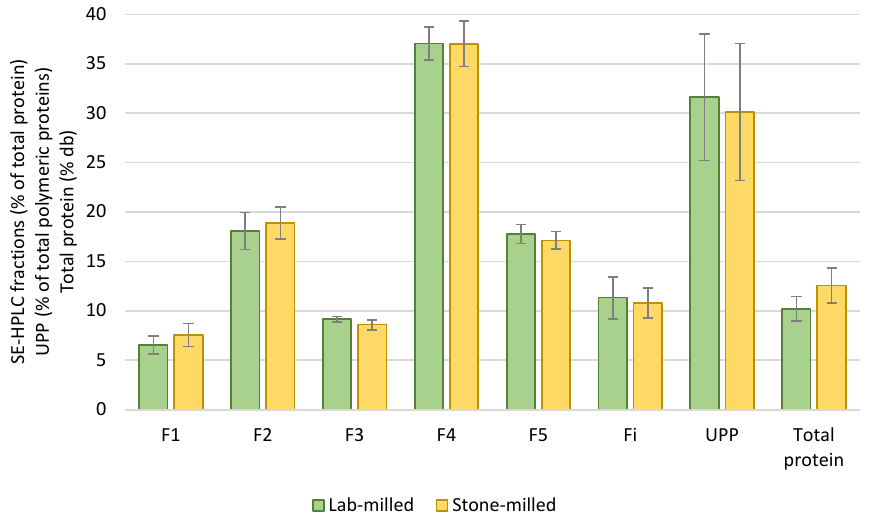
Figure 5. Comparison of the protein fractions measured on lab-milled grains and on stone-milled grains (or semolina). Means and error bars (SD) of 4 varieties: Anvergur, Claudio (IND) and Bidi17, LA1823 (FAR) harvested in 2017 (H2017) and grown under ZI conditions.